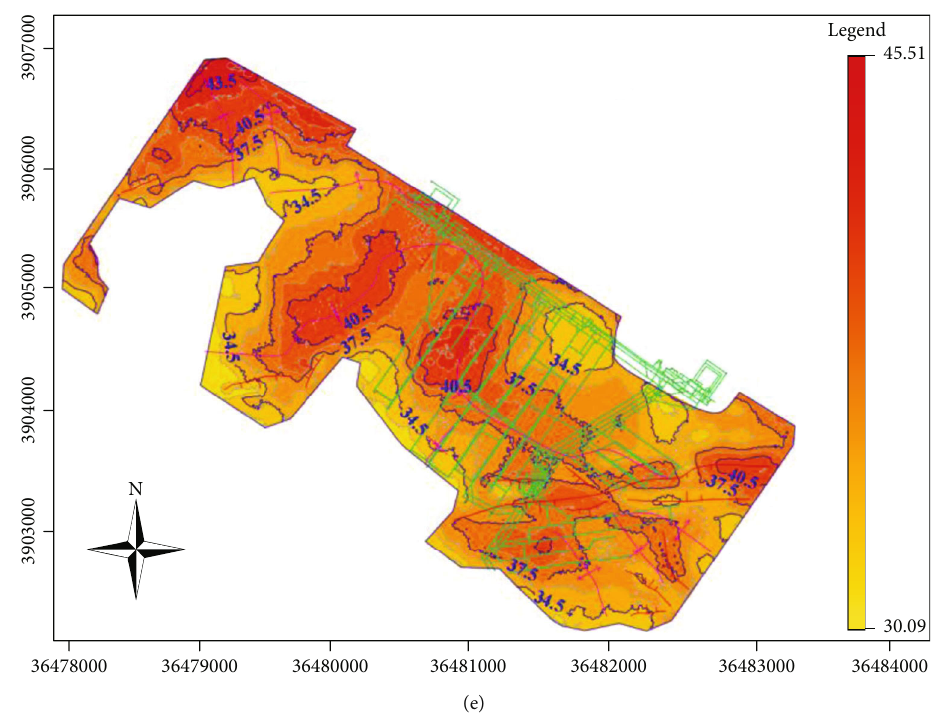
Figure 2: Thematic maps of each major in fl uencing factor. (a) Thickness of the coal seam. (b) Burial depth of the coal seam. (c) Sedimentary microfacies. (d) Geological structure. (e) Maximum horizontal principal